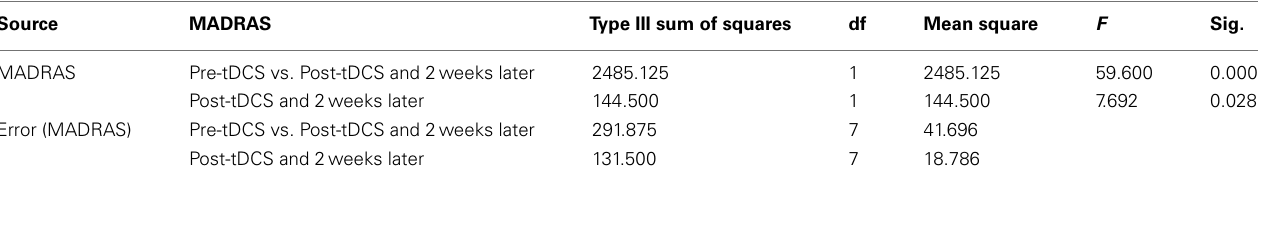
Table 2 |Tests of within-subjects contrasts for